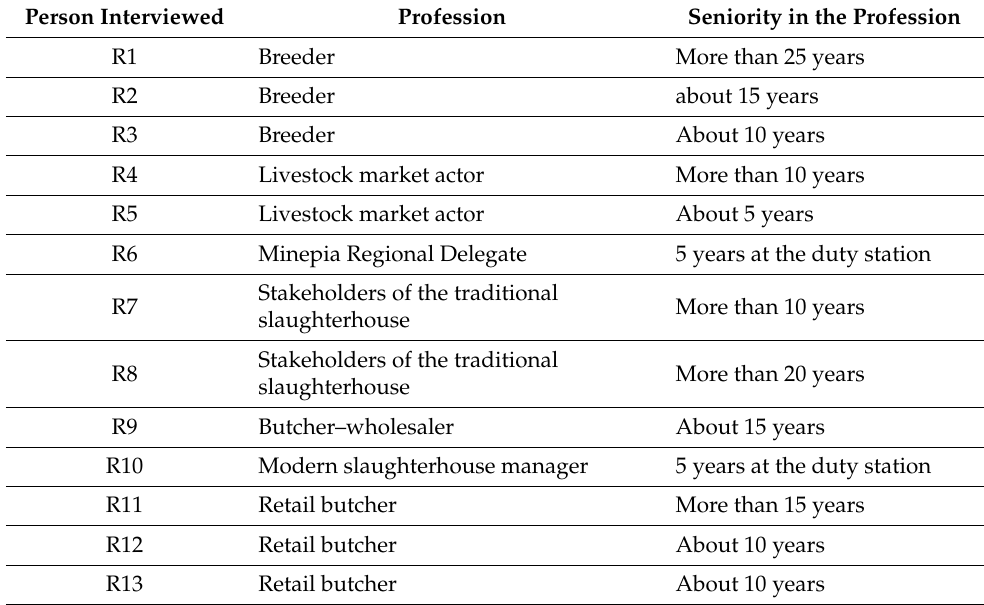
Table 4. Summary of the profile of